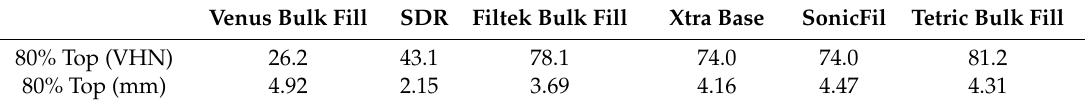
Table 3. Mean microhardness (MH at 80% of top MH and depth at 80% of max MH for bulk-fill